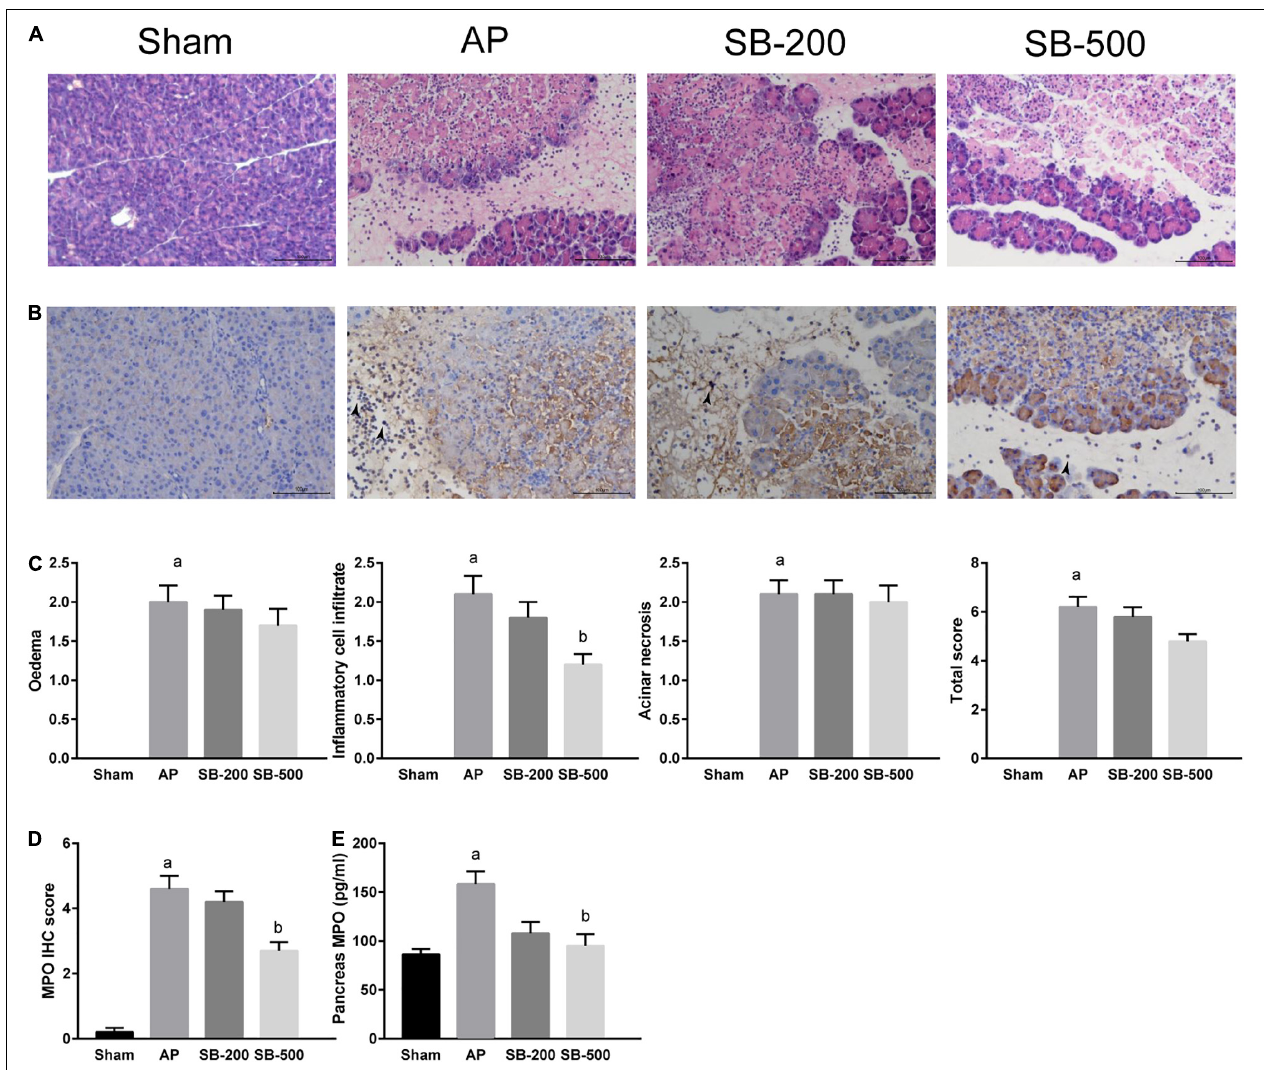
FIGURE 4 | HE and IHC staining, and concentration of MPO in the pancreatic tissue of mice in each group. (A) HE staining of the pancreatic tissue from mice in each group (x200). (B) IHC staining of MPO in the pancreatic tissue from mice in each group (x200). The black arrow indicates MPO positive cells. (C) Pathological score of HE staining of the pancreatic tissue from mice in each group. (D) IHC staining score of MPO in the pancreatic tissue in mice in each group. (E) Concentration of MPO in the pancreatic tissue from mice in each group. n = 8. The data were presented as the mean ± standard error of the mean. a p < 0.05 vs. Sham group. b p < 0.05 vs. AP group. Sham, Sham operation group; AP, acute pancreatitis group; SB-200, 200 mg/kg SB intervention group; SB-500, 500 mg/kg SB intervention group; IHC, immunohistochemical staining; MPO, myeloperoxidase; HE, hematoxylin and eosin.